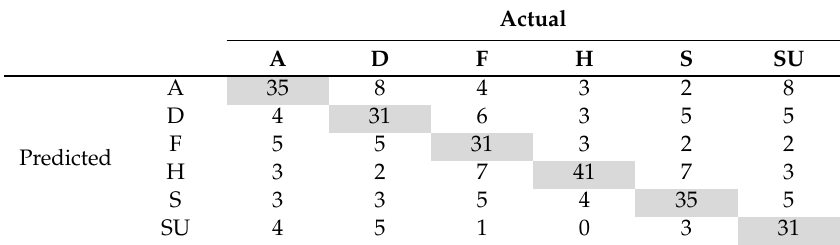
Table 4. Confusion matrix of the LBD group using the H 3 feature in KNN classification.